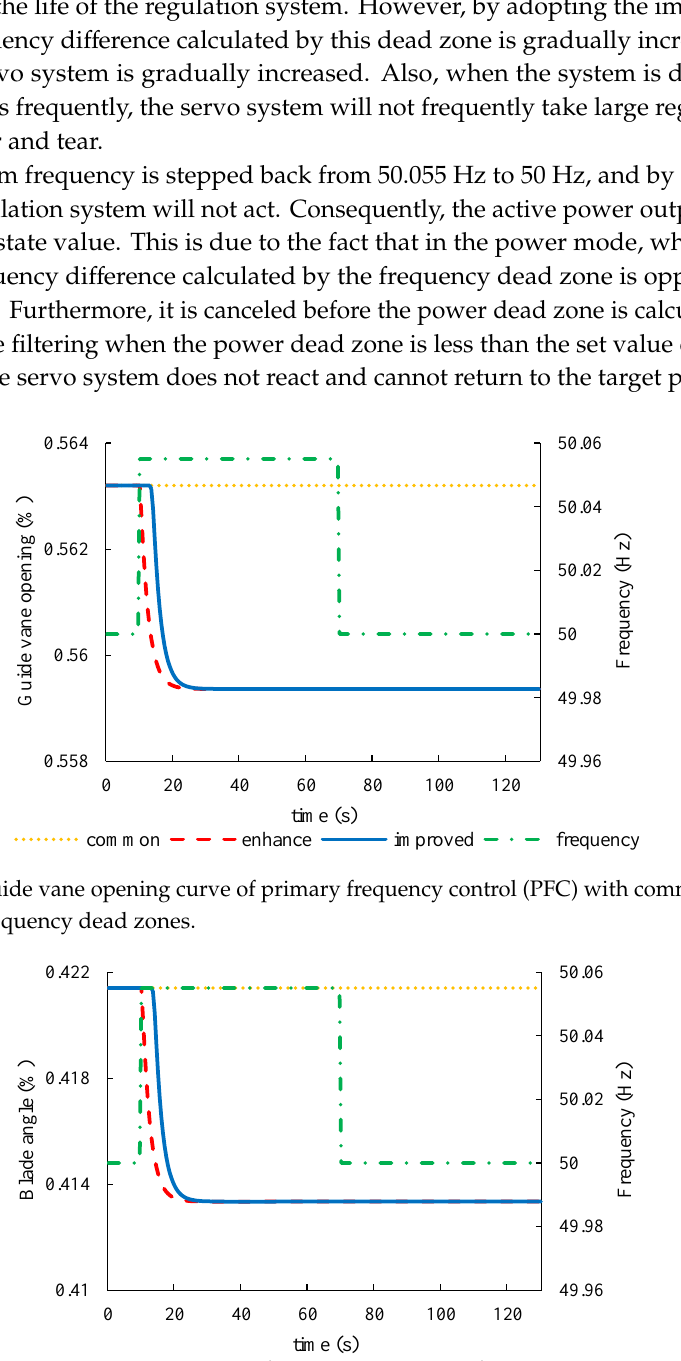
Figure 16. The active power curve of PFC with common, enhanced, and improved frequency dead zones. 4.1.2. Analysis of PFC under Common Frequency Dead Zone, Enhanced Frequency Dead Zone with Feed-Forward Control, and Improved Frequency Dead Zone with Feed-Forward Control To solve the problem discussed in Section 4.1.1 (that PFC cannot return to the target power), the feed-forward control is introduced when the enhanced frequency dead zone and the improved frequency dead zone are applied in simulation experiments. Figure 17 illustrates the dynamic response process of the guide vane opening calculations. Meanwhile, Figure 18 shows the dynamic response process of the blade angle, and Figure 19 indicates the dynamic response process of active power. After the application of the feed-forward control into the enhanced frequency dead zone and the improved frequency dead zone, the feed-forward control section calculates the current steady-state output opening Y pid as per the current frequency difference and the given power value. This guarantees that the power can be regulated back to the target power when the system frequency step falls back to 50 Hz. At the same time, as a result of the combined action of feed-forward control and PID, the regulation amount of the whole regulation process is increased,